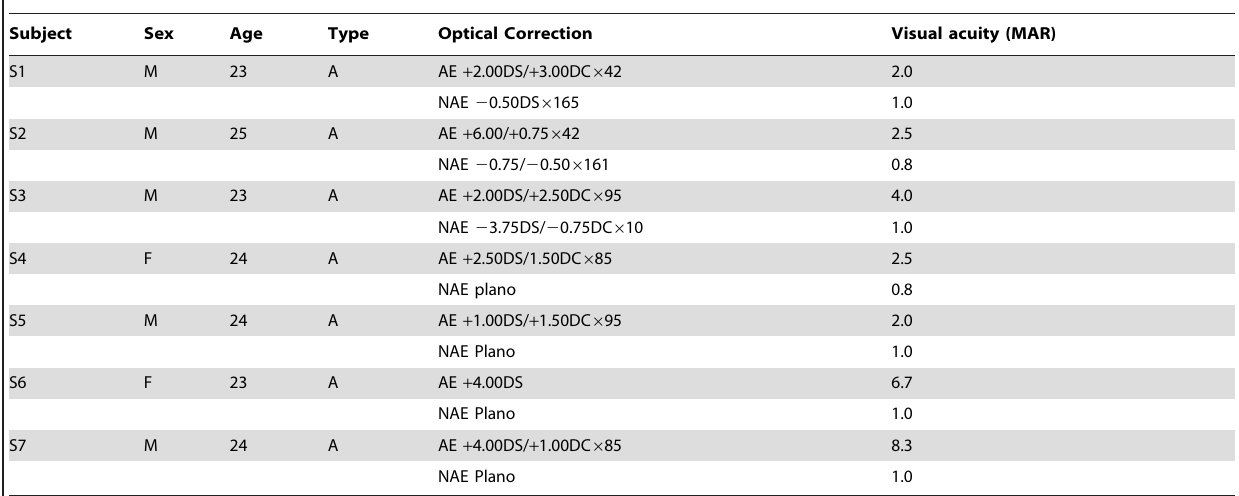
Table 1. Visual Characteristics of Amblyopic